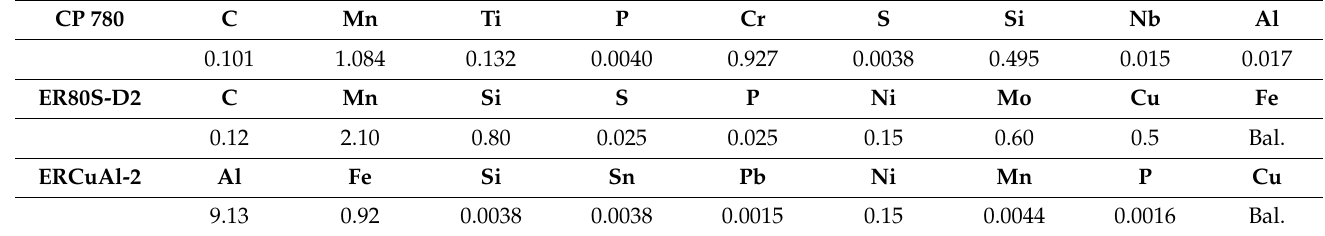
Table 1. Chemical composition of the CP-780 sheets and electrodes,